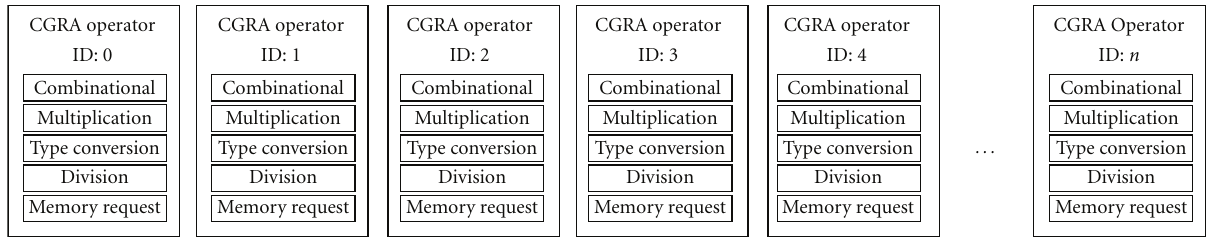
Figure 7: Configuration of the homogeneous coarse grain reconfigurable